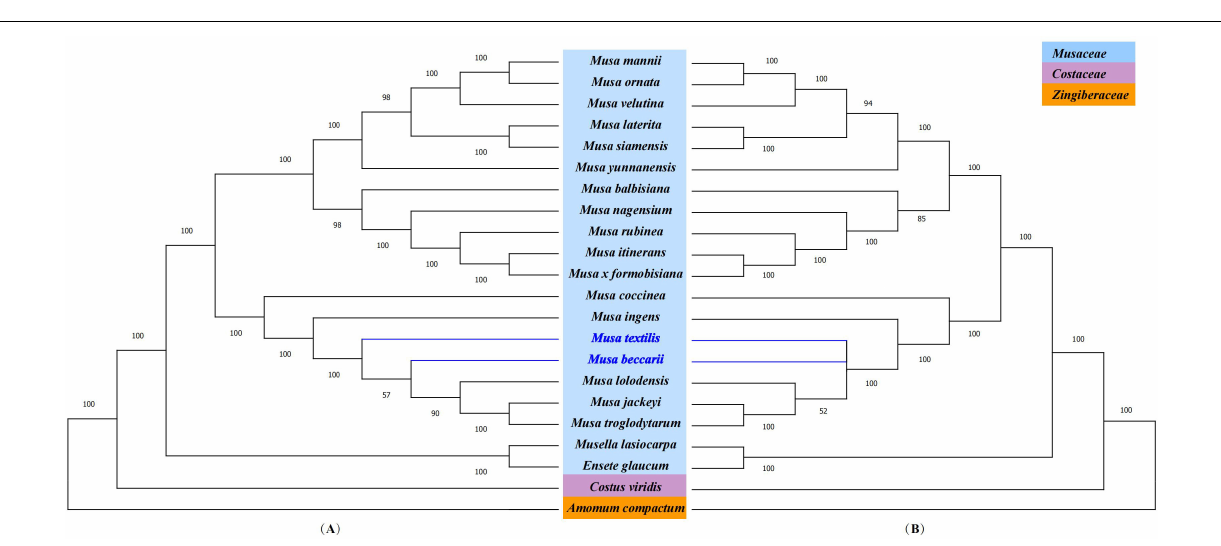
FIGURE 6 | Phylogenetic analysis. (A) Phylogenetic tree based on the complete chloroplast genome. (B) Phylogenetic tree based on shared protein-coding genes. Costus viridis and Amomum compactum were selected as out groups. Numbers at branch nodes are bootstrap